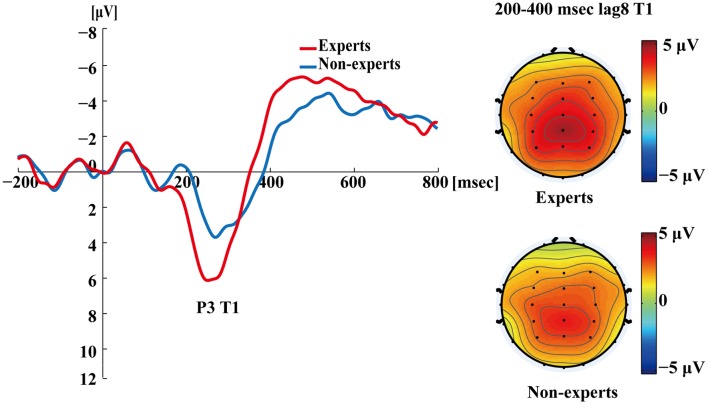
Grand averages of the mean activation at Pz of the experts and the non-experts as a function of time for lag8 trials of correct T1 identification. ERPs were time locked to the onset of T1. The scalp distribution of 200–400 ms time windows for dual-target condition at lag8 for T1.